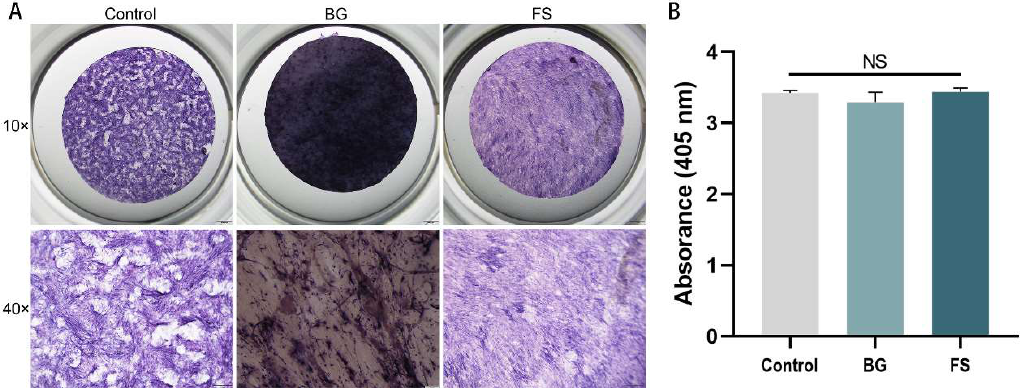
Figure 7. ALP staining ( A ) and ALP activity assay ( B ) of glass slide control, BG and FS group (NS, p > 0.05).